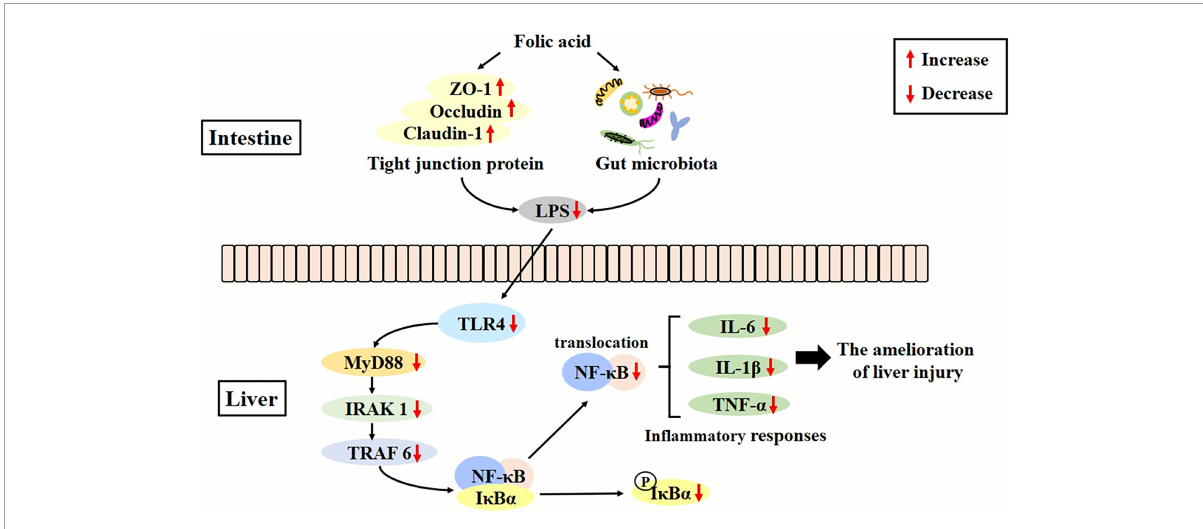
FIGURE9 Folic acid ameliorates alcohol-induced liver injury via gut–liver axis (GLA) homeostasis, mainly including the improvement of the intestinal barrier, regulation of gut microbiota, and inhibition of liver